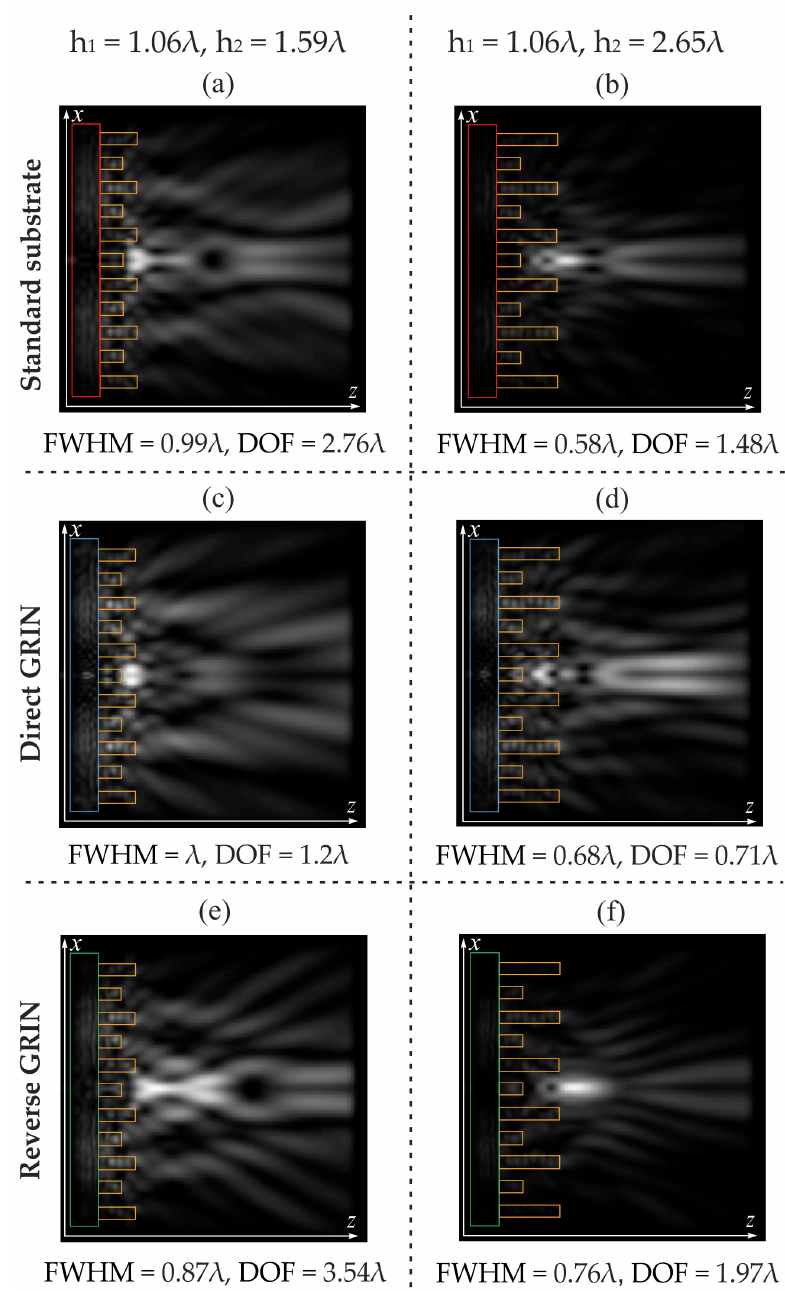
Figure 7. Two-dimensional diffraction pattern (intensity, xz plane) of the laser light propagation through annular gratings with alternating steps S for ( a , b ) a standard substrate; ( c , d ) a direct GRIN substrate; and ( e , f ) a reverse GRIN substrate.